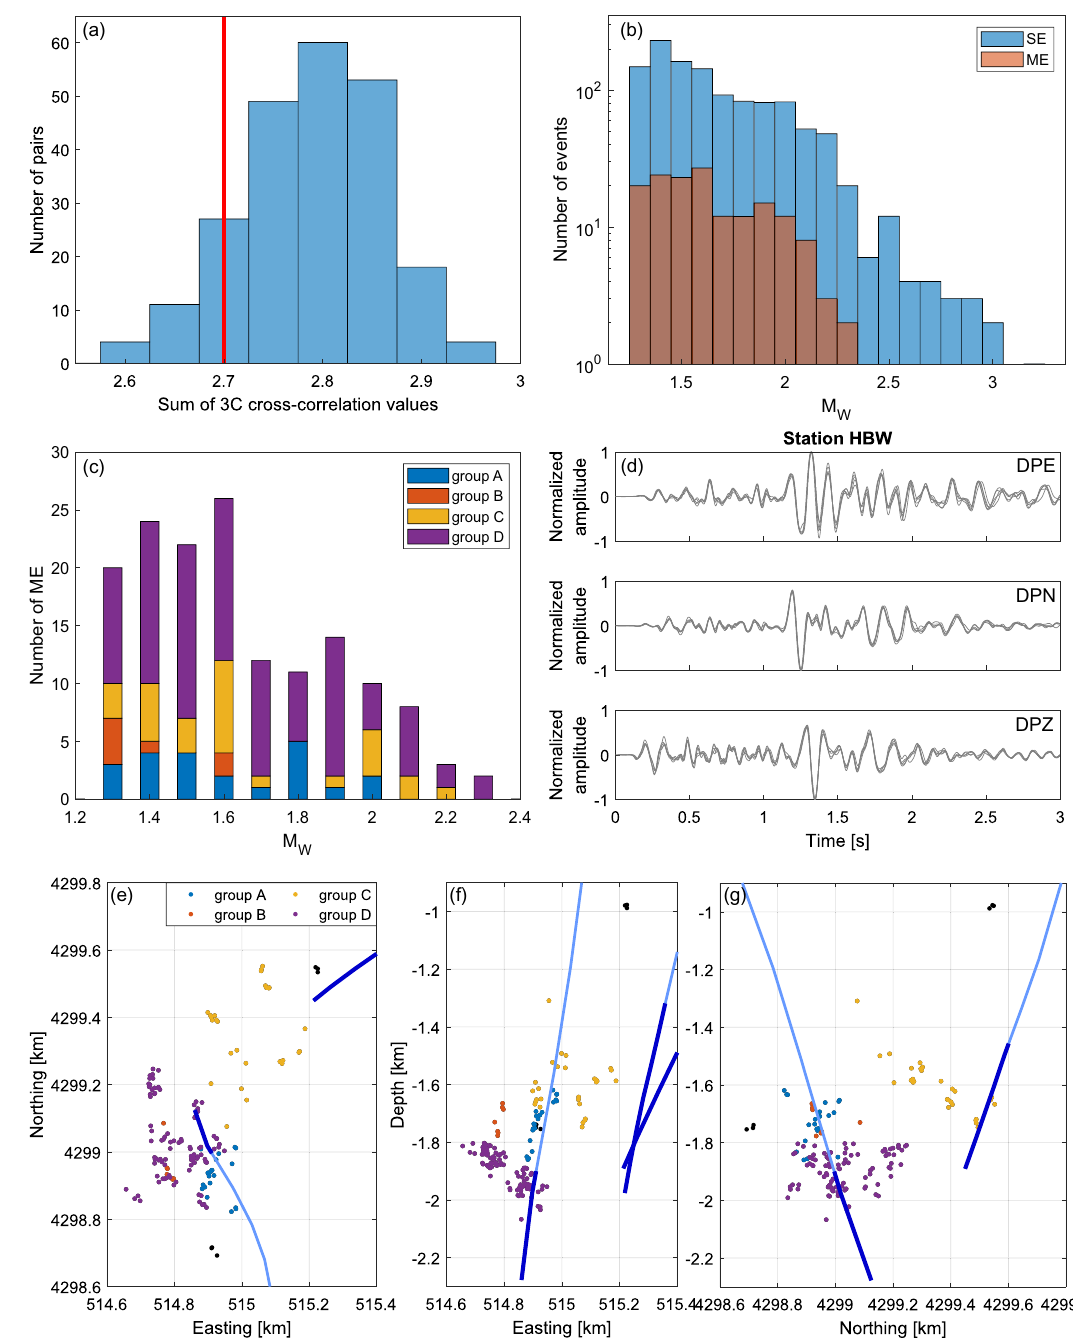
Figure 2. ( a ) Median three component cross-correlation values on all stations for all event pairs within identified multiplets, ( b ) moment magnitudes of all ME and SE, ( c ) moment magnitudes of ME from groups A–D, ( d ) example of the multiplet consisting of 5 events: overlaid signals after filtration to 1–15 Hz, station HBW, 3 components, ( e – g ) relocated ME and distinguished ME groups